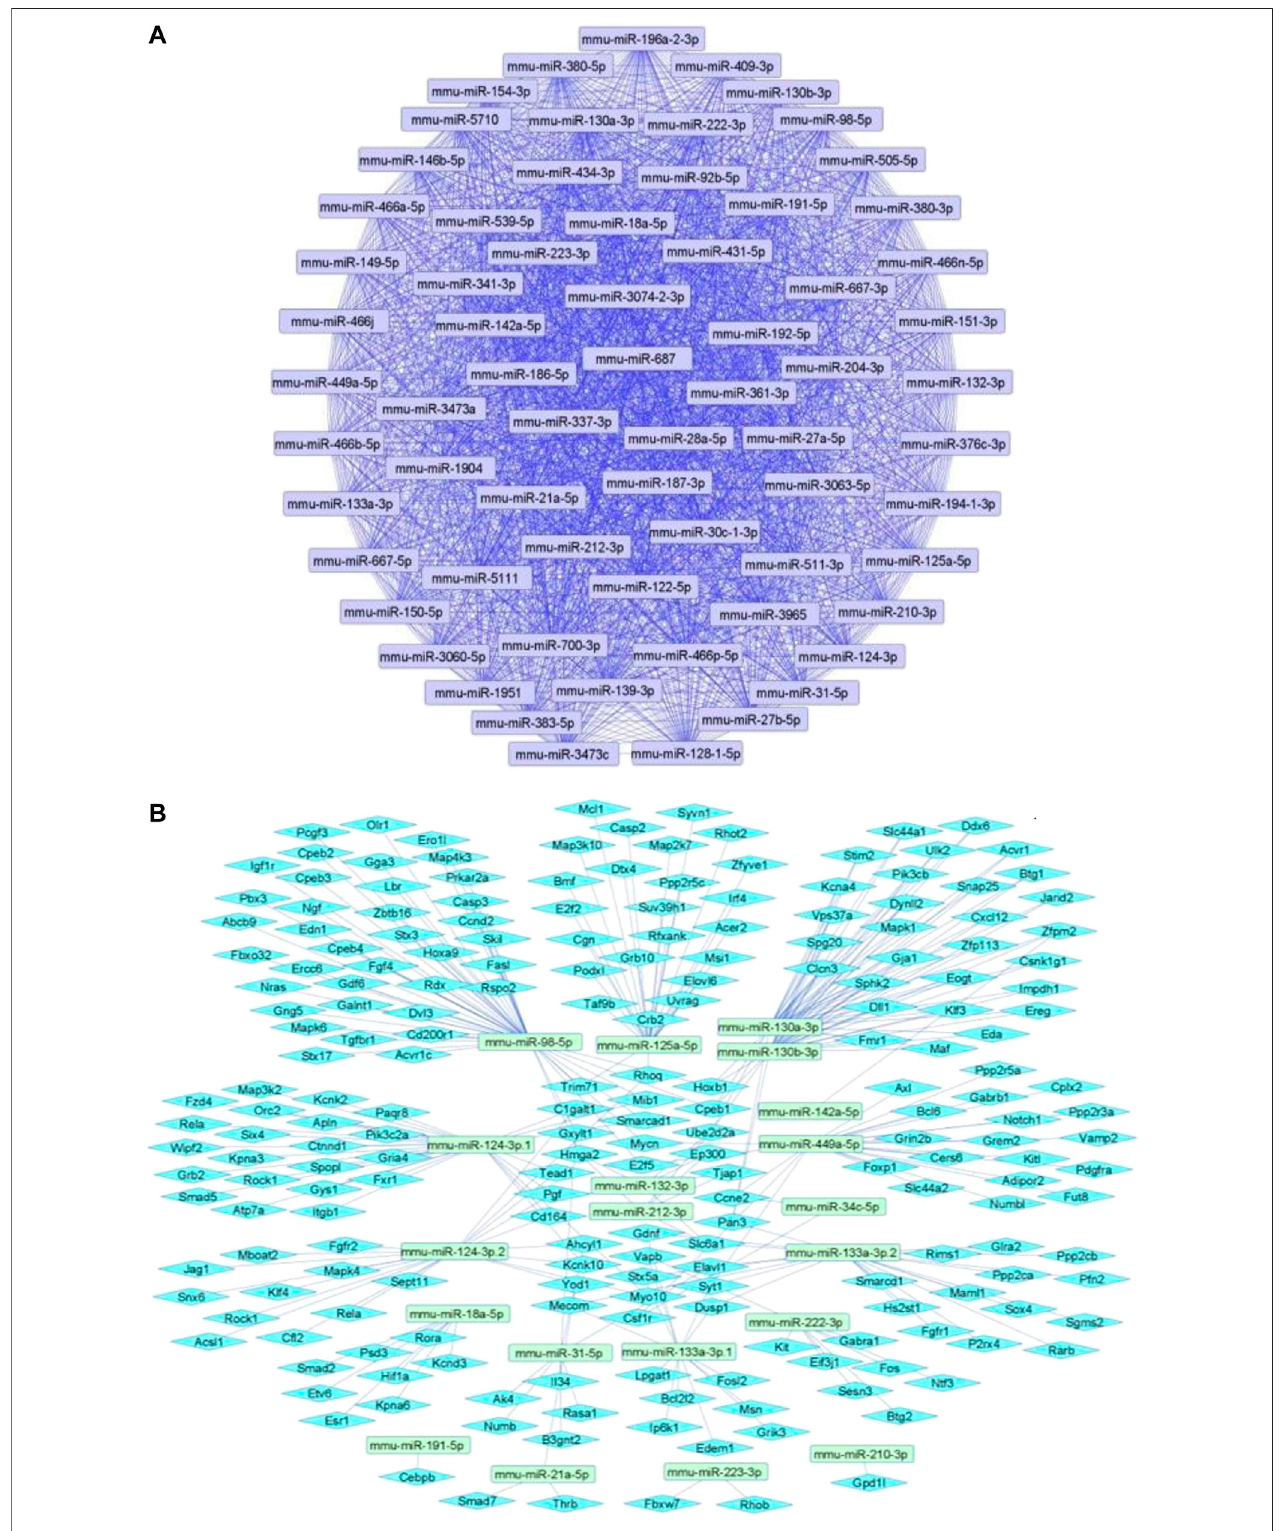
FIGURE 2 | Upregulated mouse microRNA networks in neuropathic pain: (A) Mouse microRNA – microRNA network: Mouse miRNA-miRNA interaction network with 68 nodes and 2,278 edges. The networks were constructed using Cytoscape 3.8.2. (B) Mouse microRNA – gene target network: Architecture of networks of upregulated miRNAs in mouse implicated in neuropathic pain showing interaction network of functionally enriched miRNAs with their targets with 237 nodes and 287 edges.ThenetworkswereconstructedusingCytoscape3.8.2.UsingMienturnet,themiRNA-targetinteractionswereidenti fi edbyTargetScanandthefunctionally enriched miRNAs were generated using the KEGG database.